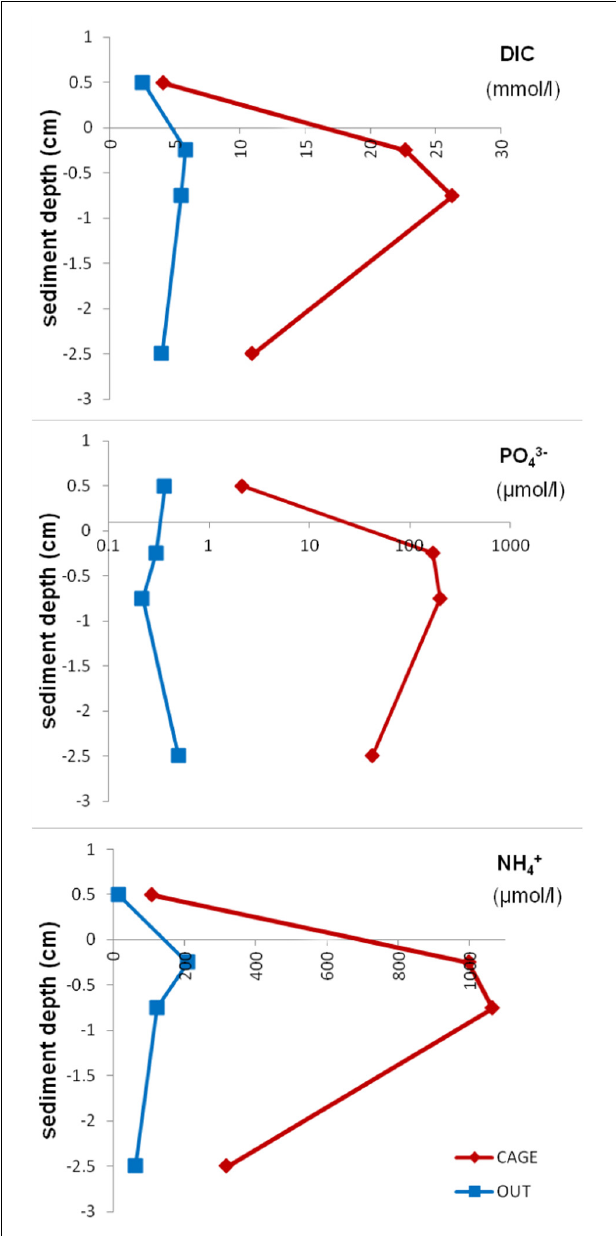
FIGURE 6 | Dissolved inorganic carbon, phosphate, and ammonium concentration in pore water in different layers of CAGE and OUT samples. Note that the x -axis for phosphate is in the logarithmic